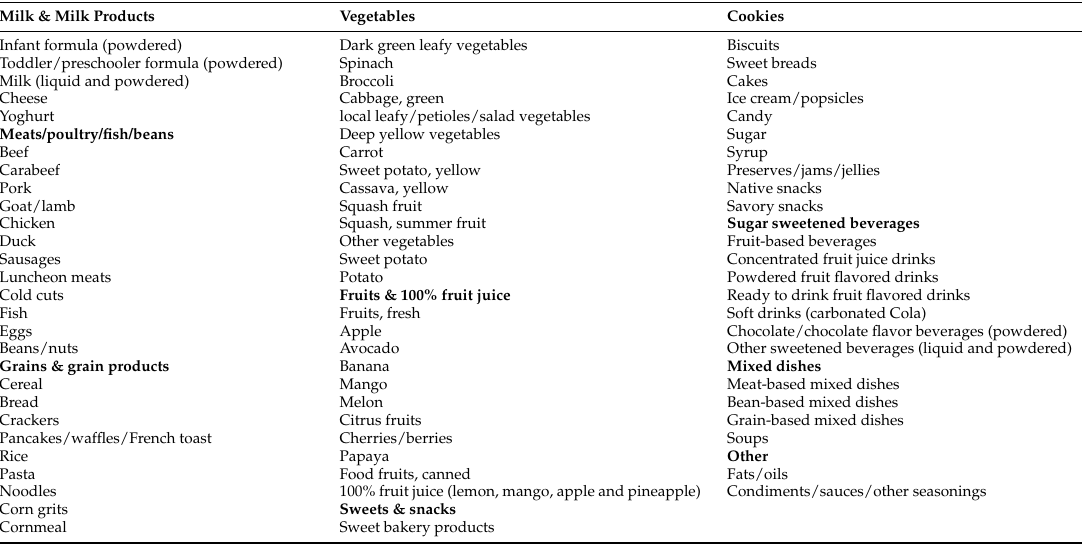
Table 1. Food group